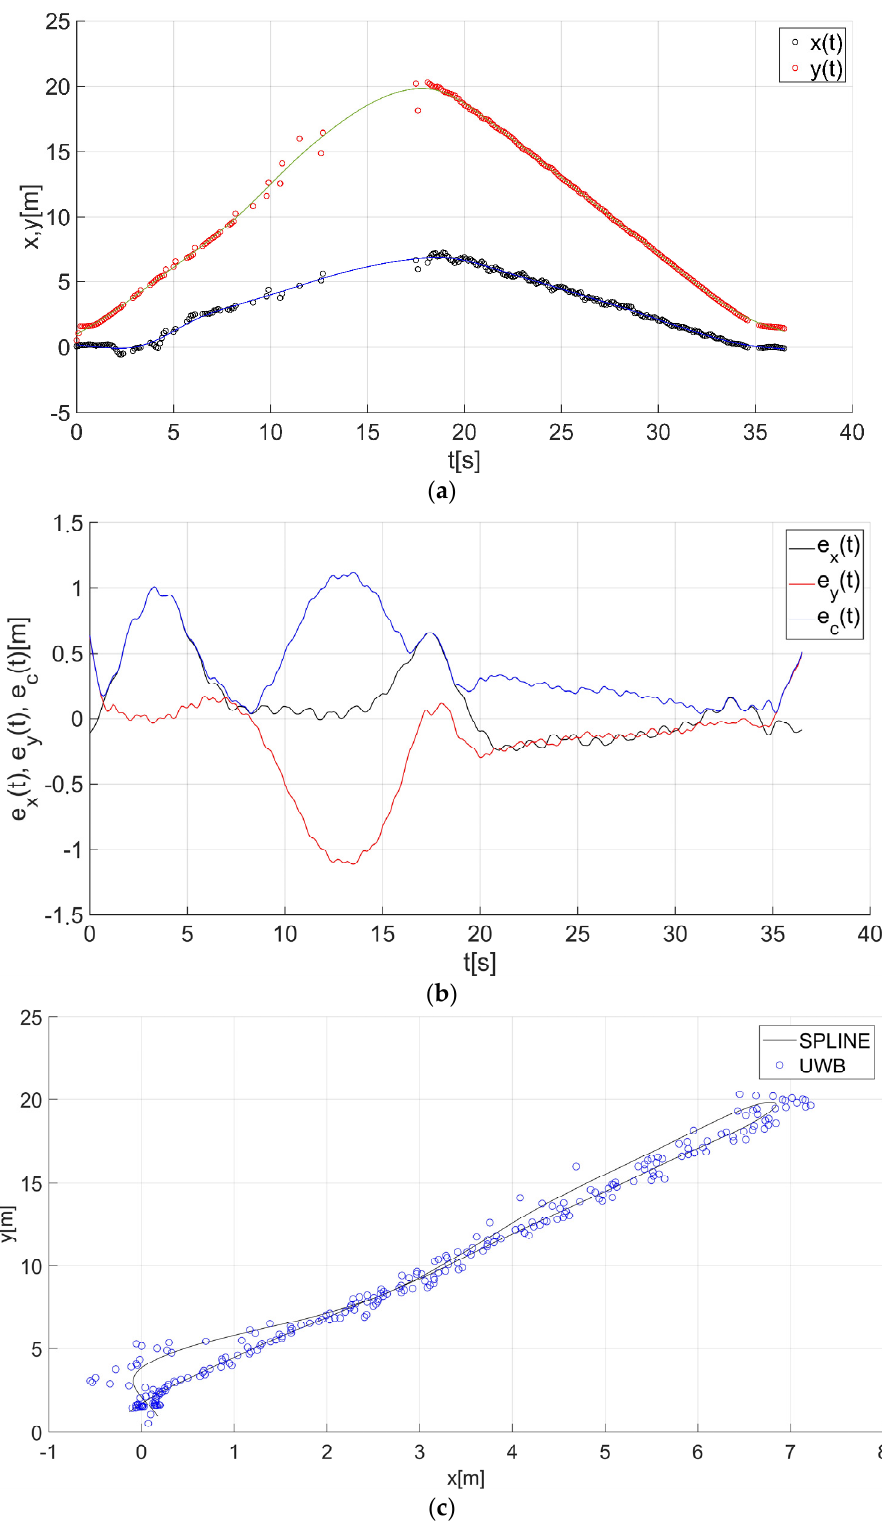
Figure 17. Results for the estimation of guide path no. 5 with the use of the smoothing spline: ( a ) the course of the guide’s location coordinates x(t), y(t) with their continuous estimates, ( b ) the course of the estimated location errors e x (t), e y (t), e c (t), ( c ) guide’s location along with the path estimation [6].